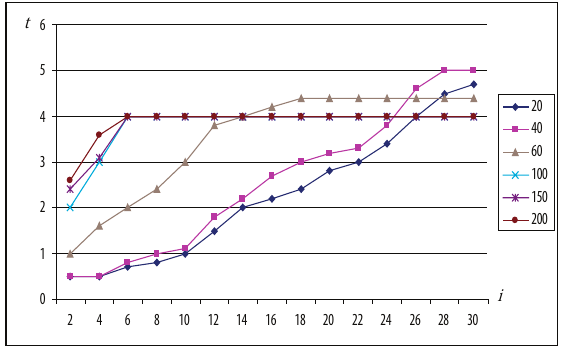
Fig. 5. Dependence of algorithm convergence rate on initial population number